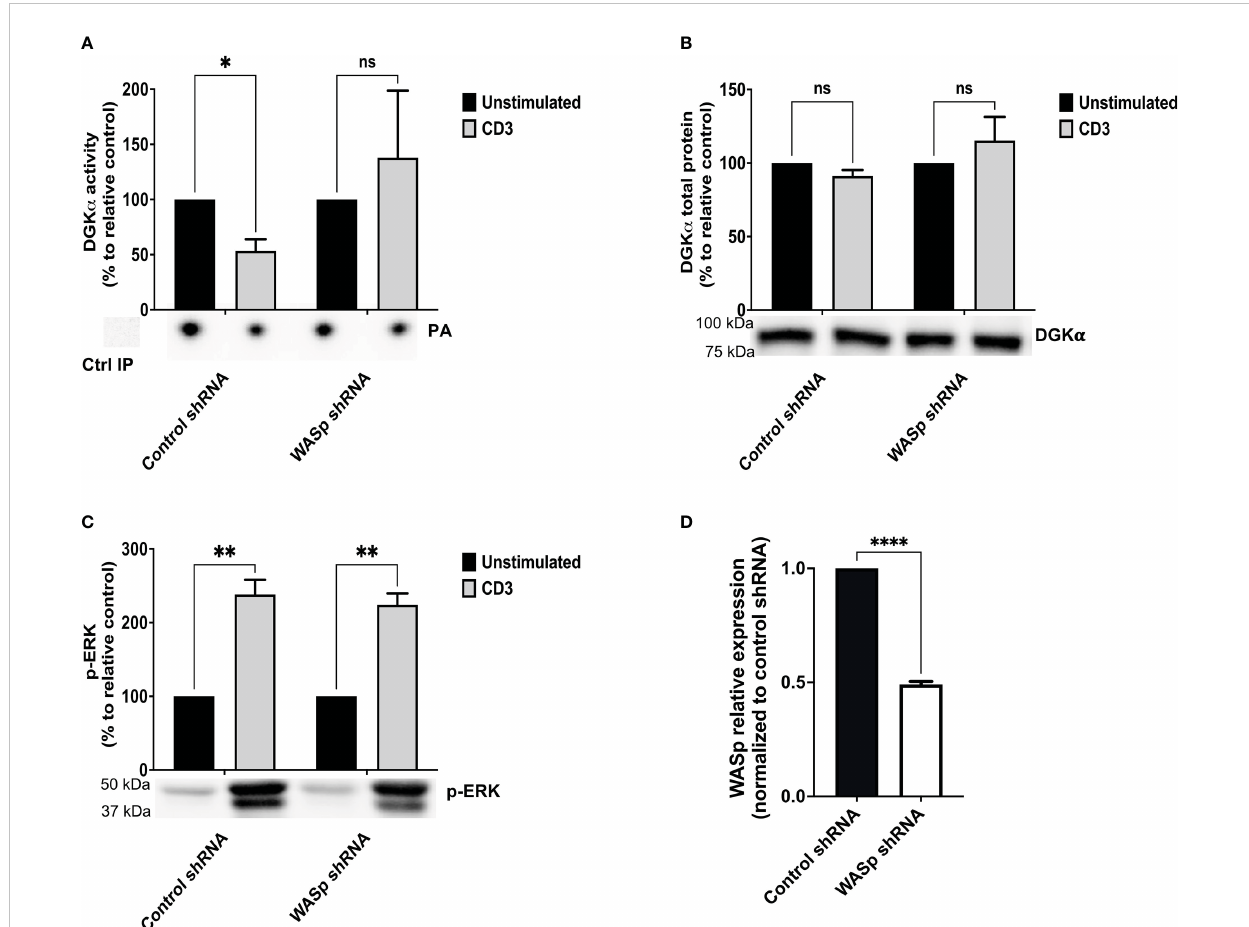
FIGURE 1 WASp is required for DGK a inhibition upon CD3 stimulation Control shRNA and WASp shRNA Jurkat cells (3 x 10 7 ) were stimulated with CD3 agonist (UCHT1 10 m g/ml for 15 minutes). Post-stimulation, cells were lysed and: (A) immunoprecipitated with anti-DGK a antibody followed by DGK activity assays; the lower panel is a representative assay and upper panel is the mean ± SEM of 4 experiments normalized as the % of unstimulated cells. (B) Total cell lysates were analysed by western blotting with anti DGK a antibodies; the lower panel is a representative blot and upper panel is the mean ± SEM of 4 experiments normalized as the % of unstimulated cells. (C) Total cell lysates were analysed by western blotting with anti-pERK antibodies; the lower panel is a representative blot and upper panel is the mean ± SEM of 4 experiments normalized as the % of unstimulated cells. (D) WASp mRNA levels were measured by qRT-PCR at three different timepoints during the experiments and shown as mean ± SEM using control shRNA as reference. ns, non signi fi cant. A single, double, triple, and four asterisks denote their signi fi cance of a p-value ≤ 0.05, ≤ 0.01, ≤ 0.001 and ≤ 0.0001 respectively in all